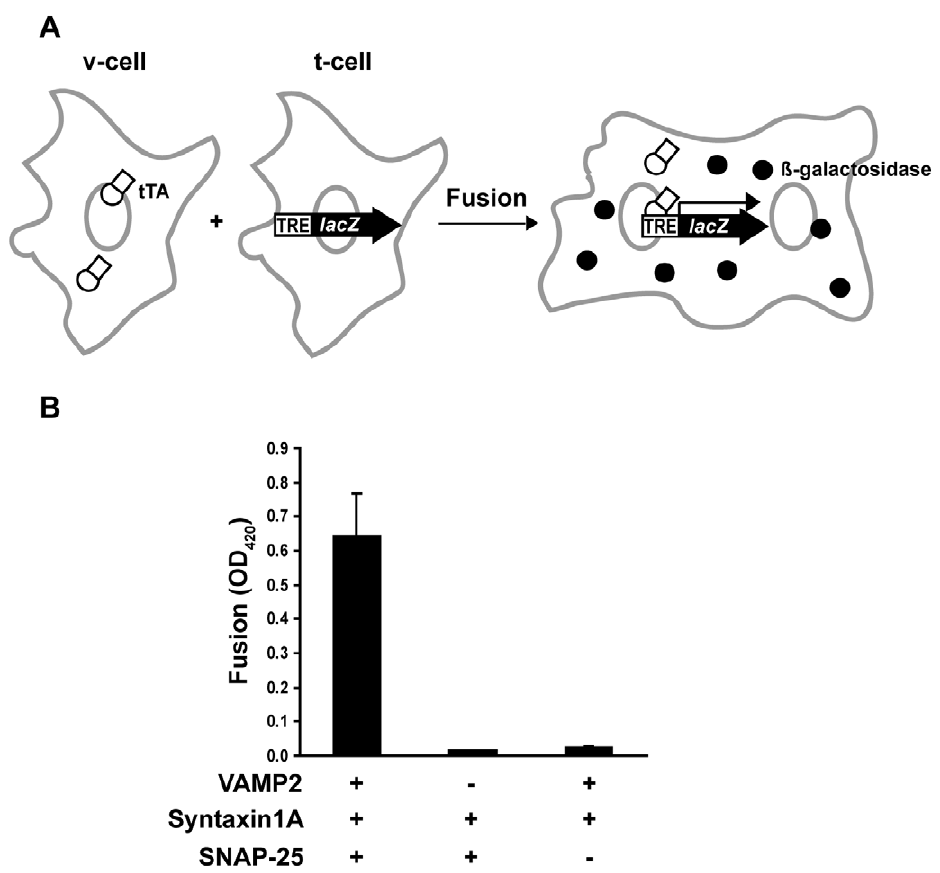
Figure 1. Enzymatic cell fusion assay. (A) In COS-7 cells that expressed v-SNARE proteins on the surface (v-cells), flipped v-SNARE was cotransfected with a plasmid that encodes the tetracycline-controlled transactivator (tTA). In COS-7 cells that expressed t-SNARE proteins on the surface (t-cells), flipped t-SNAREs were cotransfected with a reporter plasmid that encodes b -galactosidase under control of the tetracycline-response element (TRE- LacZ ). 24 h after transfection, v-cells were detached from cell culture dishes, and then overlaid on t-cells. Fusion of the v- and t-cells led to the binding of tTA to TRE and expression of b -galactosidase. (B) Cell fusion depends on the interactions of v- and t-SNAREs. v-cells that expressed tTA and VAMP2 were incubated with t-cells that expressed TRE- LacZ , syntaxin1 and SNAP-25. After 24 h, the cells were lysed and the activity of b - galactosidase in the lysates was determined using a colorimetric method by absorbance at 420 nm. Only baseline b -galactosidase activity was detected when either flipped VAMP2 or SNAP-25 was omitted from transfection. Error bars represent standard deviation of four independent experiments.